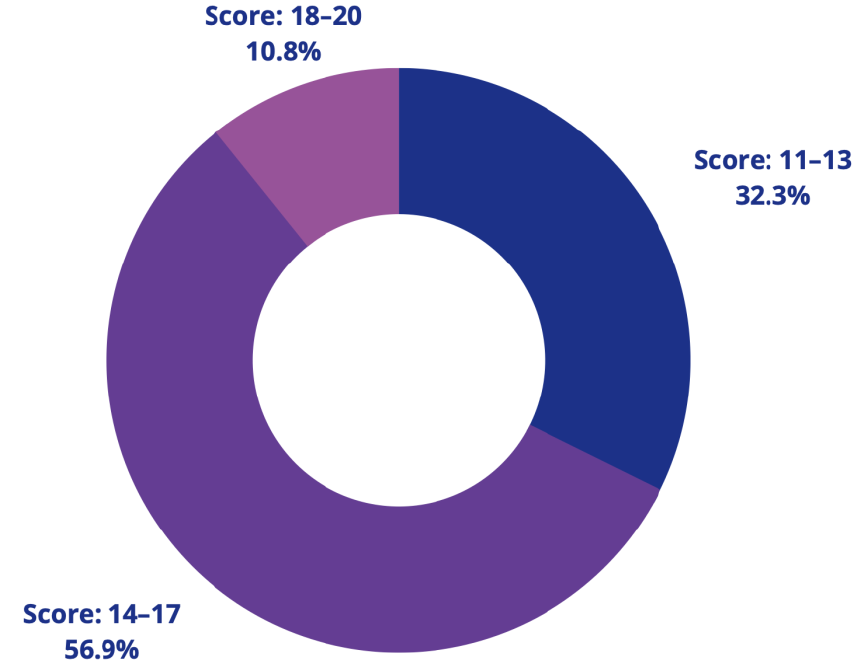
Figure 2. Result of quality assessment of 65 papers.